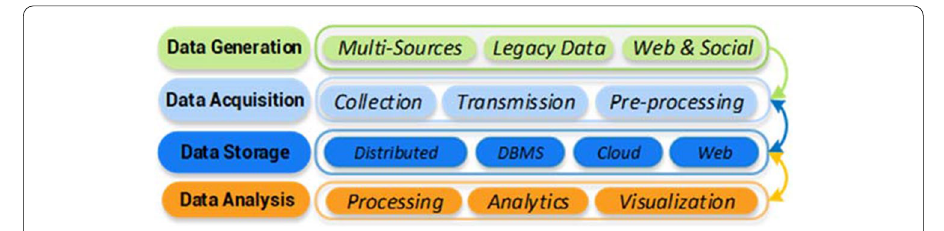
Fig. 1 Big data lifecycle value